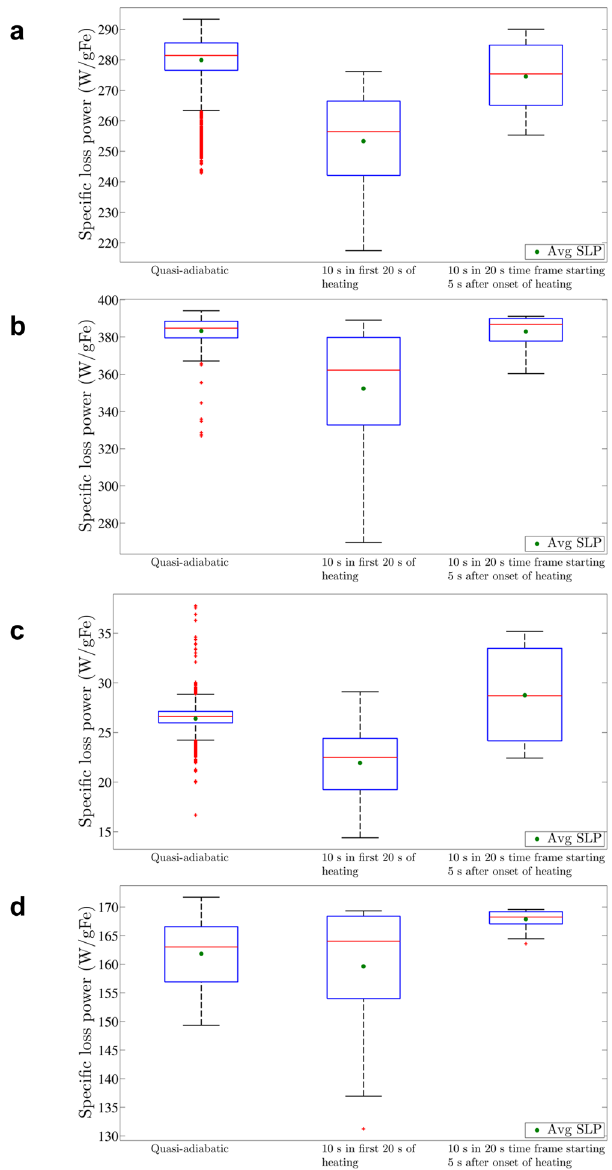
Figure 6. Box-and-whisker plot of SLP values obtained when applying different criteria to the same measurement performed at 150 kHz and 20 kA/m for BNF-Dextran nanoparticles ( a ), JHU nanoparticles ( b ), nanomag ® -D-spio ( c ), and MnFe 2 O 4 nanoparticles ( d ). The first criterion is our proposed (quasi)-adiabatic criterion, whereas the second represents all 10 s periods in the first 20 s of heating. The third criterion also includes every 10 s period, but in a 20 s timeframe starting 5 s after onset of